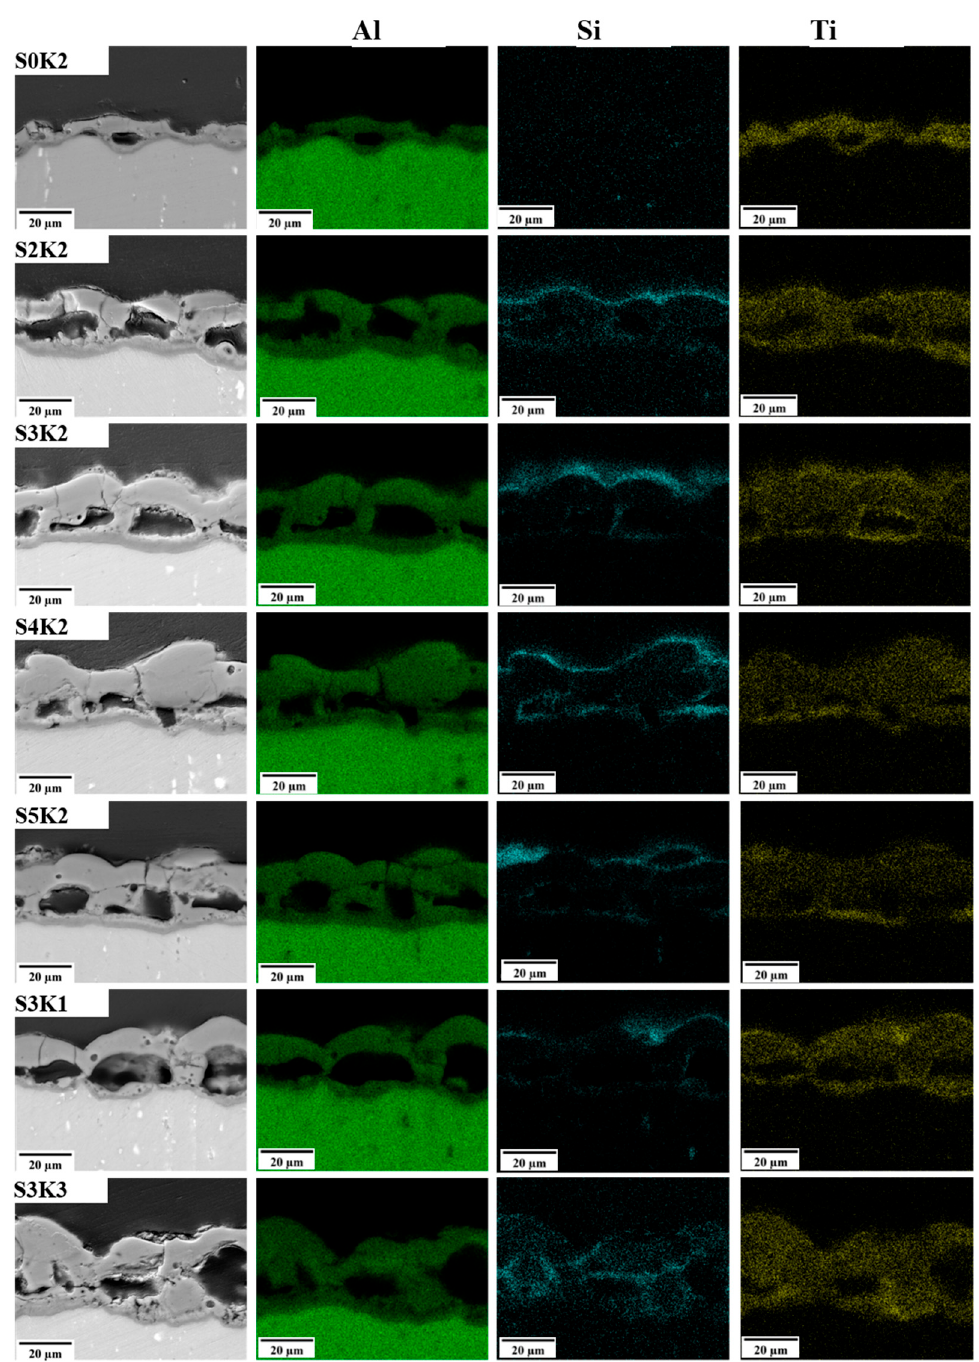
Figure 5. Elemental map on the cross-section of the PEO specimens prepared from coating solutions containing different concentrations of SMS and KOH.